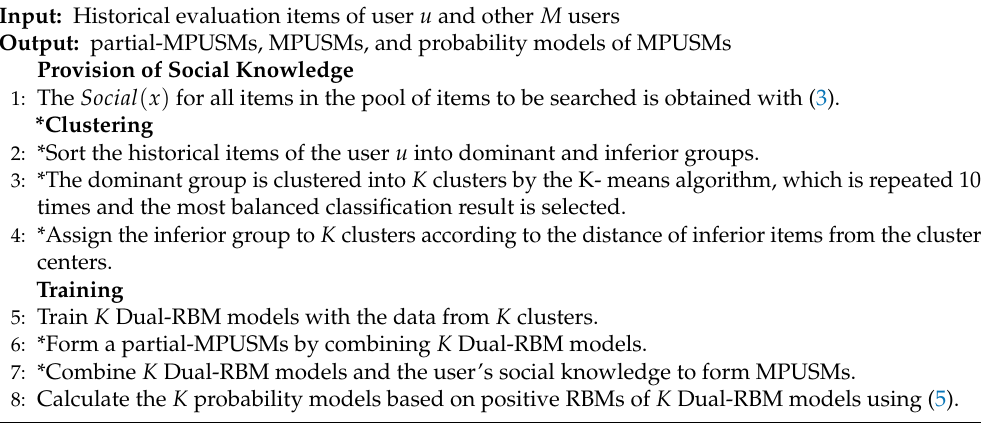
Algorithm 2 Pseudocode for the procession of creating MPUSMs and their